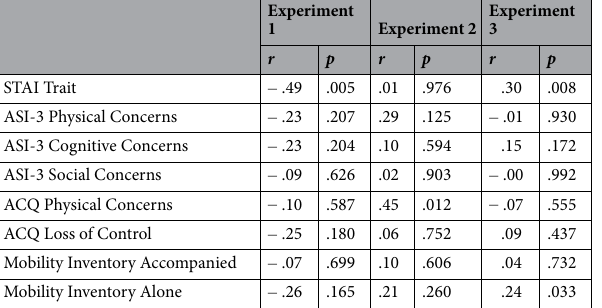
Table 3. Correlations between anxiety measures and center entries. STAI = State-Trait Anxiety Inventory; ASI-3 = Anxiety Sensitivity Index—3, ACQ = Acoraphobic Cognitions Questionnaire, MI = Mobility